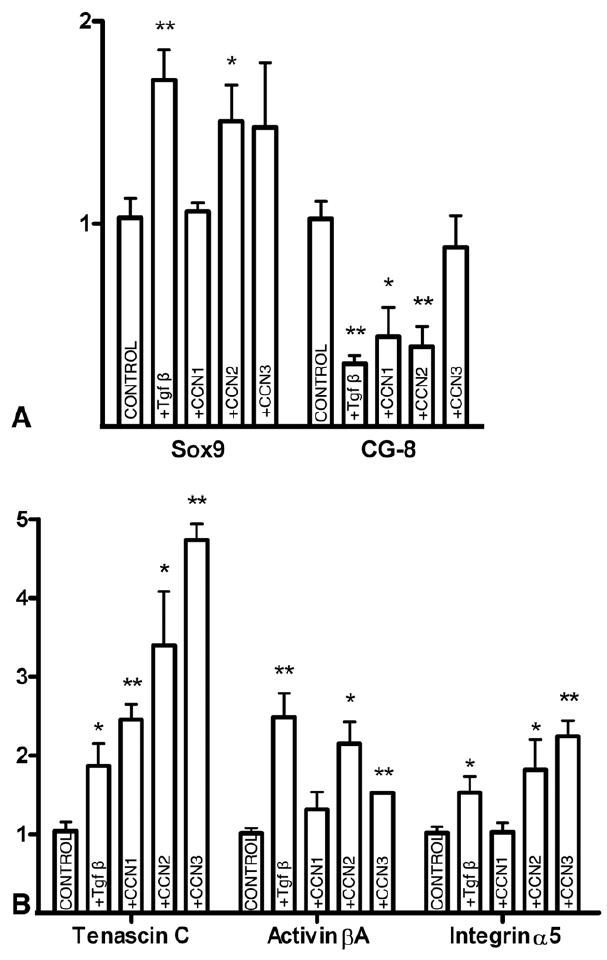
Figure 4. Regulation of chondrogenic factors by CCN proteins. Charts showing the regulation of Sox9 , Scleraxis , and CG-8 (A); and Tenascin C , Activin b A and alpha 5 Integrin (B) in the interdigital mesoderm 6 hr after the implantation of beads bearing PBS (first column, control), Tgf b (second column), CCN1 (third column), CCN2 (fourth column) and CCN3 (fifth column). (*) p-value # 0.05; (**) p-value # 0.01.